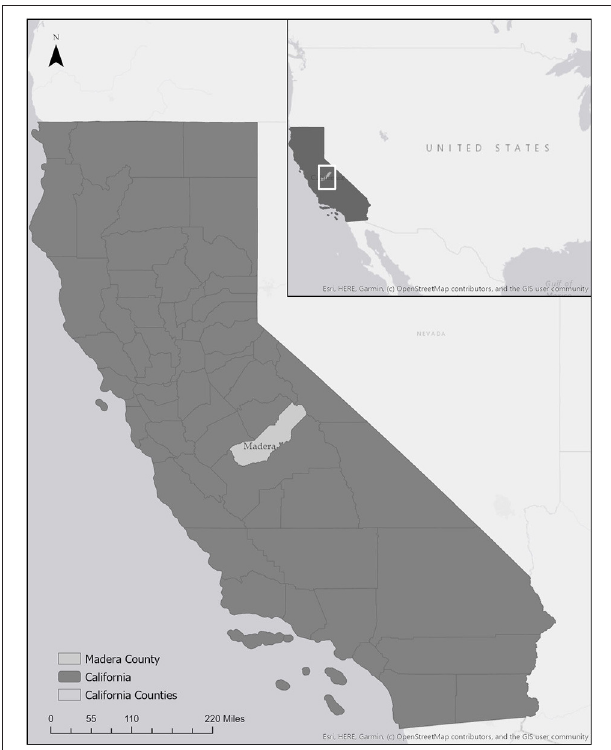
FIGURE 1 | Map of Madera County,